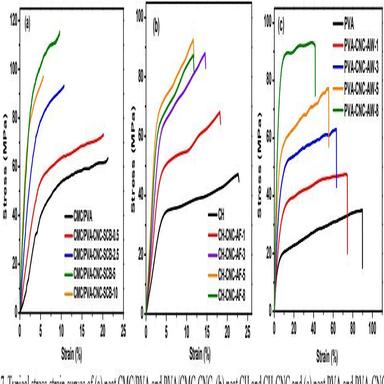
Typical stress-strain curves of (a) neat CMC/PVA and PVA/CMC-CNC, (b) neat CH and CH-CNC and (c) neat PVA and PVA-CNC nanocomposites